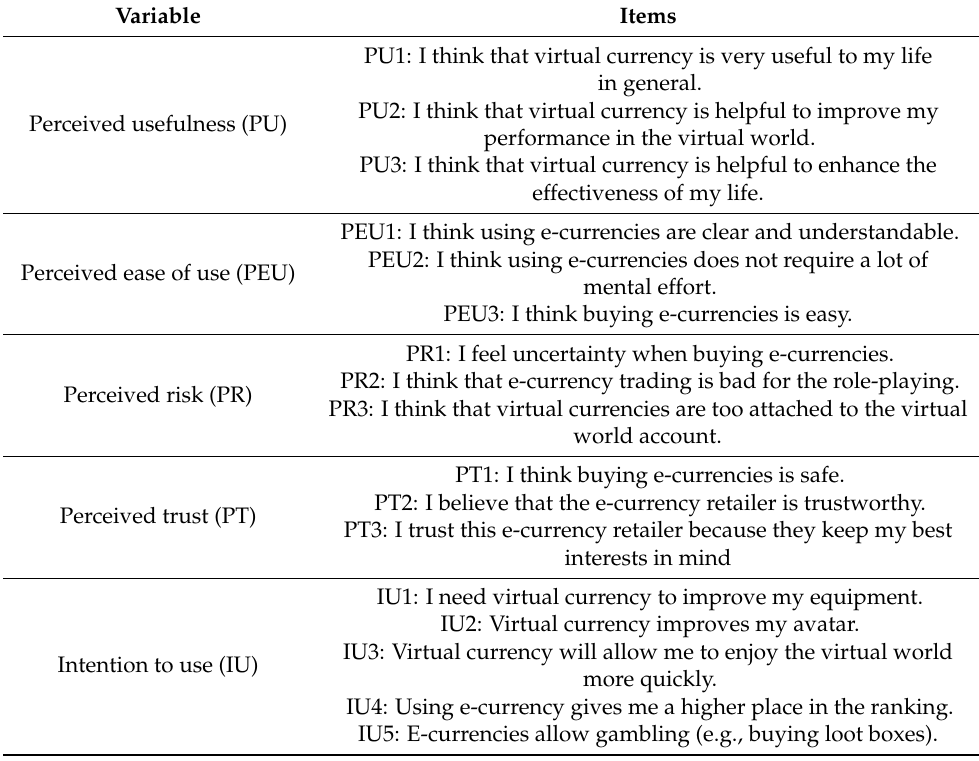
Table 2. Summary of variables and items measured in the